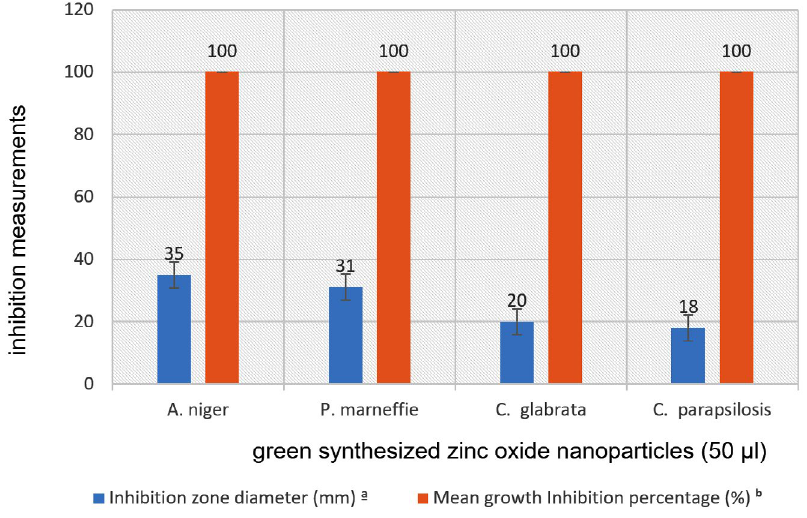
Fig. 11. Anti-fungal activity of ZnONPs against the tested fungal strains diameter of inhibition zone and mean growth inhibition